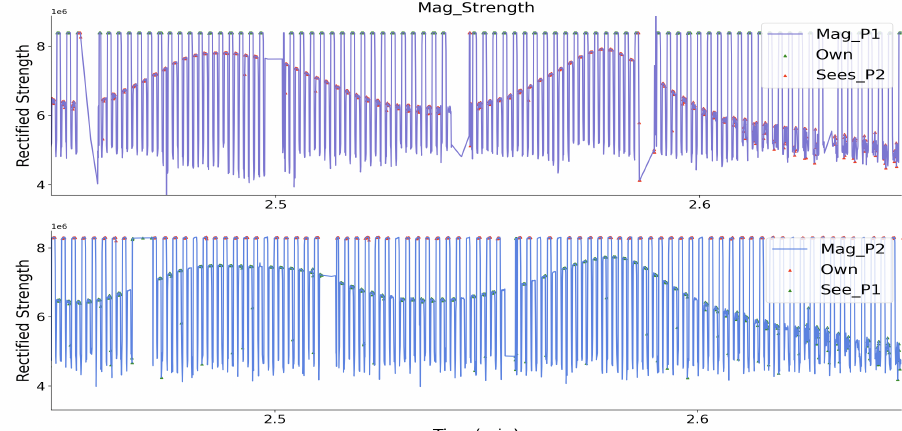
Figure 16. A close look of TDMA (Time-division multiple access) based strength signal from two prototypes during a randomly walking-by, the peaks with constant amplitude indicates the field strength from its’ own transmitter, the peaks with a varying amplitude indicates the field strength from another prototype, which indicates the actual